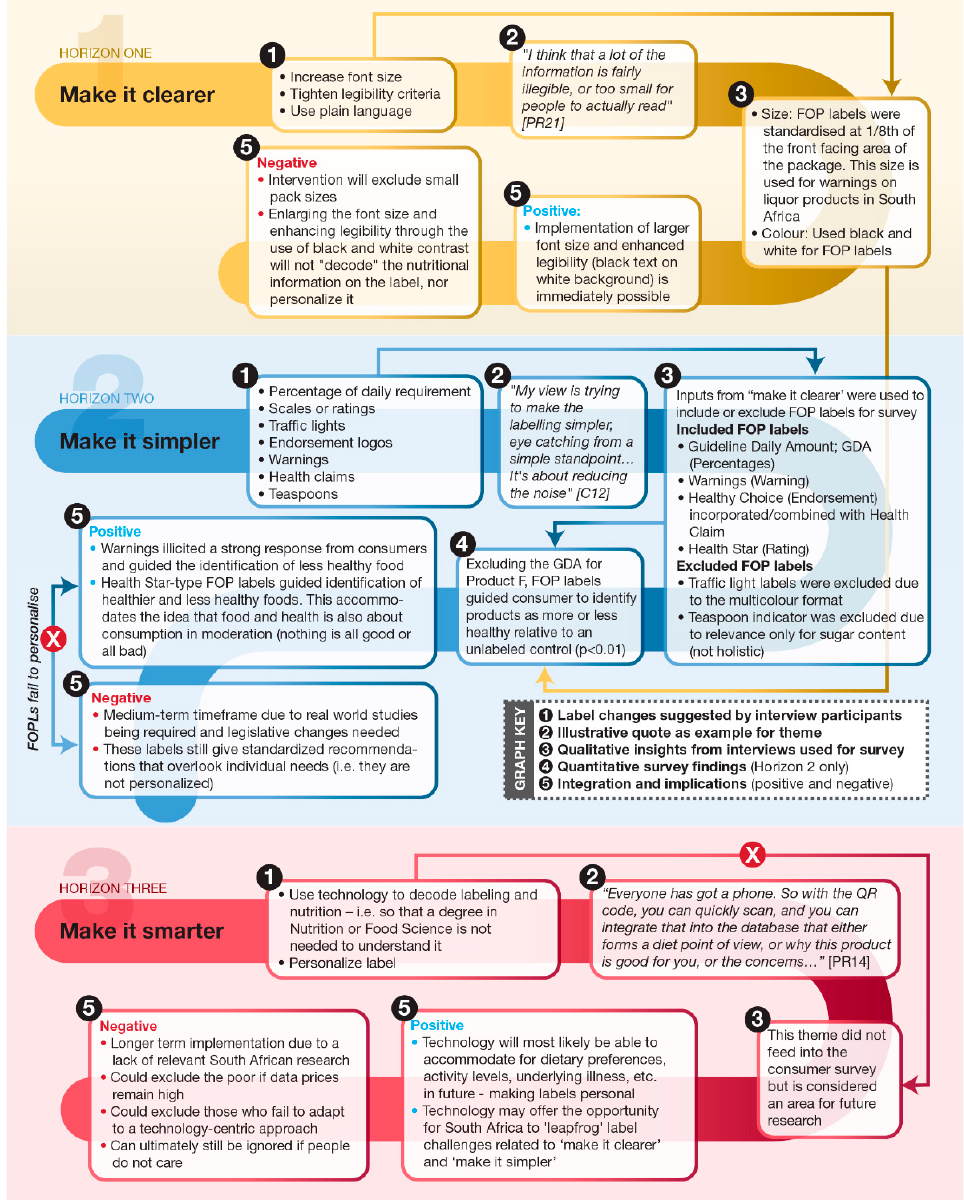
Figure 5. Joint display integrating interview themes with survey outcomes to illustrate the positives and negatives of a staged approach to implementing FOP labeling in South Africa. FOP: Front-of pack.